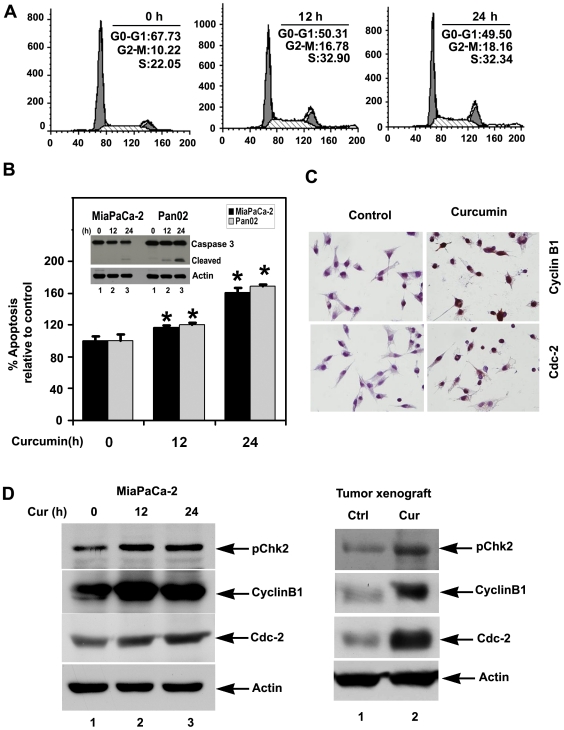
Curcumin induces mitotic catastrophe.A) Cell cycle profiles of MiaPaCa-2 cells treated with curcumin for 12 h and 24 h and were determined by flow cytometry using propidium iodide staining for DNA content. Curcumin treatment significantly increased cells in the S and G2M phase of cell cycle within 12 h. (B) Curcumin treatment induces apoptosis. MiaPaCa-2 and Pan02 cells incubated with 30 µM of curcumin were analyzed for apoptosis by caspase 3/7 activation. Curcumin treatment increased the number of cells undergoing apoptosis compared to untreated controls (*p<0.05). (Inset) Curcumin induces caspase 3, an apoptosis mediator. Lysates from MiaPaCa-2 or Pan02 cells incubated with 30µM curcumin were analyzed by western blotting for caspase 3 protein. Curcumin treated cells shows cleaved (activated) caspase 3 while untreated cells have no cleaved caspase-3. (C) Curcumin treatment increased the levels of cyclin B1, Cdc-2 and phosphorylated checkpoint kinase Chk2. Lysates from curcumin treated MiaPaCa-2 cells (left) and Pan02 tumor xenografts (right) were analyzed by western blotting for phospho Chk2, and cyclin B1 and Cdc-2 protein expression levels. Curcumin treatment phosphorylates checkpoint kinases and increased levels of cyclin B1 and Cdc-2 in both MiaPaCa-2 cells and Pan02 tumor xenografts. (D) Curcumin treatment results in nuclear localization of cyclin B1 and Cdc-2. Immunocytochemistry of curcumin treated with MiaPaCa-2 cells both the cyclinB1 and Cdc-2 protein levels were predominately in the nucleus compared than untreated cells. Phosphorylation of Chk2, coupled with increased expression and nuclear translocation of cyclin B1 and Cdc-2 demonstrates mitotic progression of cells.